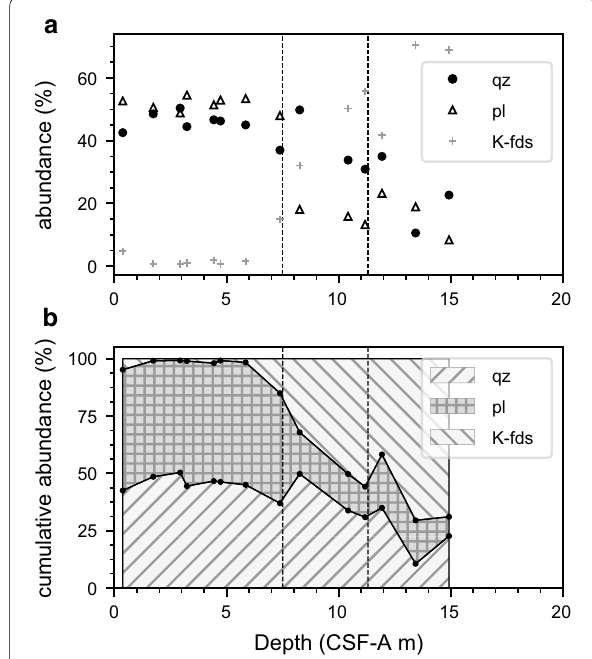
Fig. 4 Depth variation of silicate mineralogy of the quartz and feldspars separate. a Relative abundance of quartz (qz, filled circles), plagioclase (pl, open triangles), and potassium feldspar (K-fds, crosses). b Stack plot of the relative abundance. Vertical dashed lines represent lithostratigraphic unit boundaries